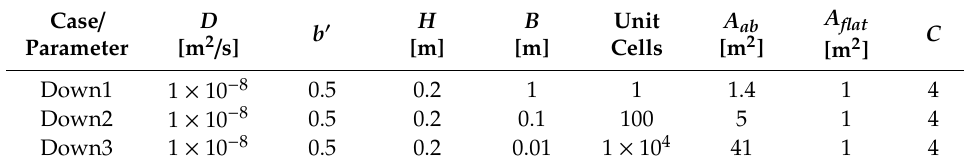
Table 1. Values of parameters for the modelling of the Down-flow SPB storage.